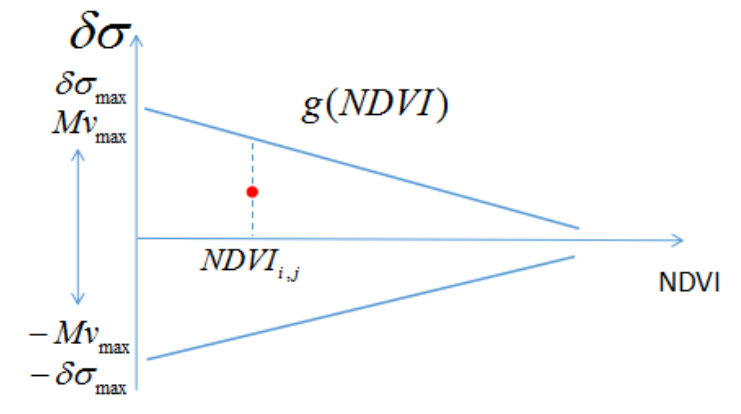
Figure 6. Illustration of method 2.